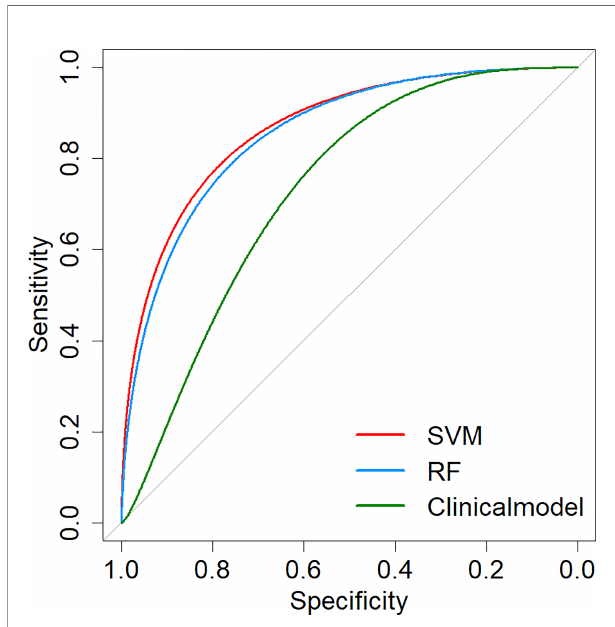
FIGURE 6 | ROC curves of prediction models. SVM, Support Vector Machine; RF, Random Forest; ROC, Receiver operating characteristic.